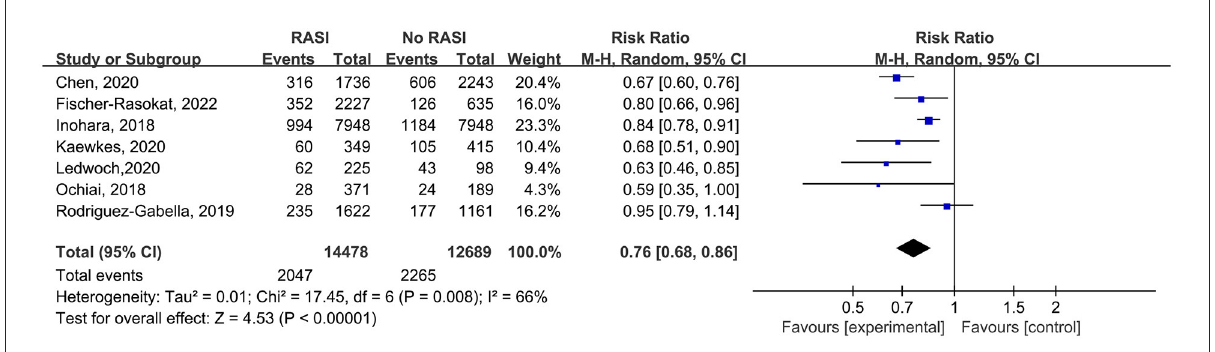
FIGURE2 Forest plots of random-effects meta-analysis for the rate of all-cause mortality.